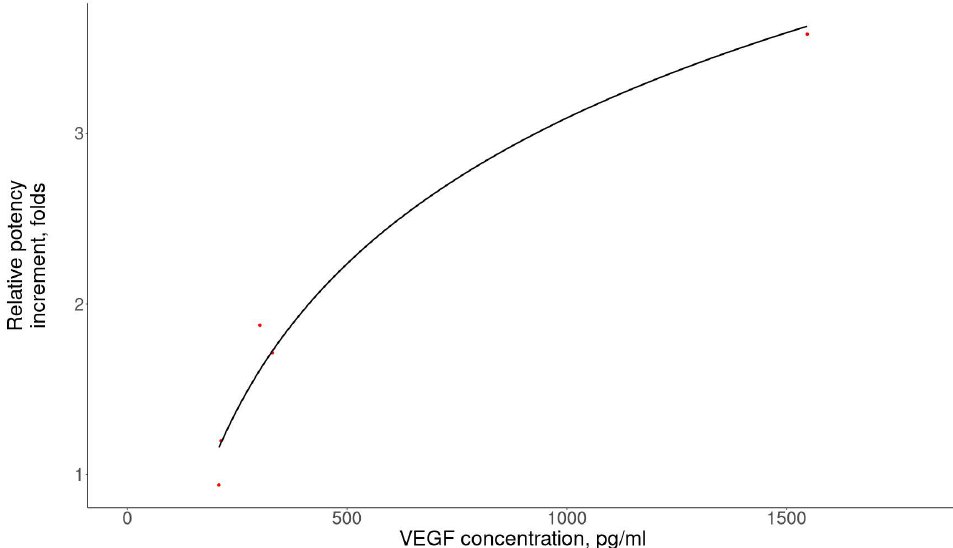
Figure 2. The VEGF concentration in the MSC secretome was directly associated with the potency increment (testosterone secretion) compared to cells from the control group (R = 0.9, p = 0.083, Spearman’s test). The Y axis represents the ratio of the testosterone concentration after MSC secretome treatment to the testosterone concentration in the control without the MSC secretome. The correlation was calculated using Spearman’s test. Red dots indicate independent